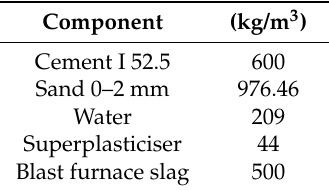
Table 1. Matrix M1 composition.